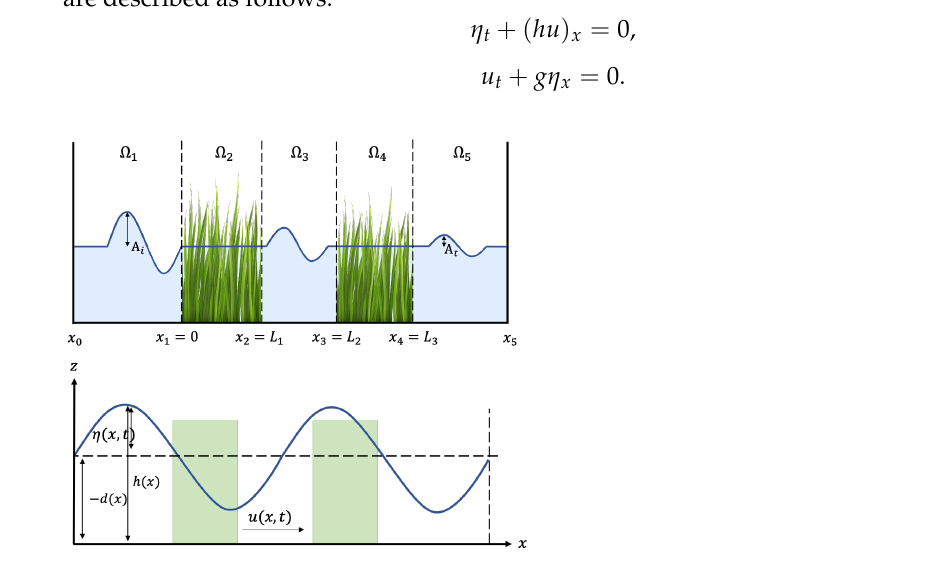
Figure 1. Sketch of the 1-D Observation